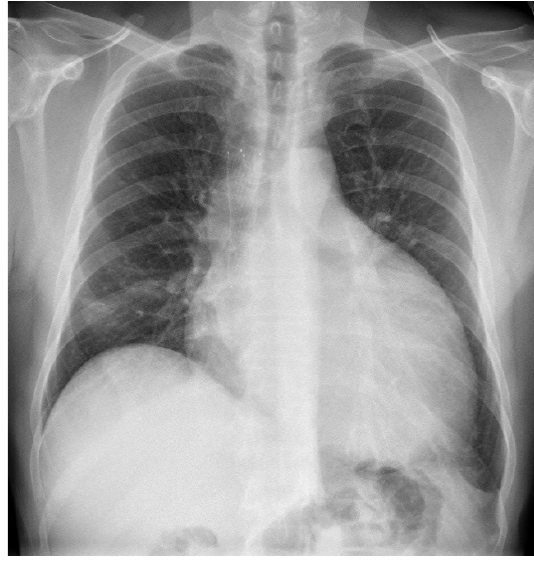
Figure 3. Chest X-ray. Enlargement of pericardial